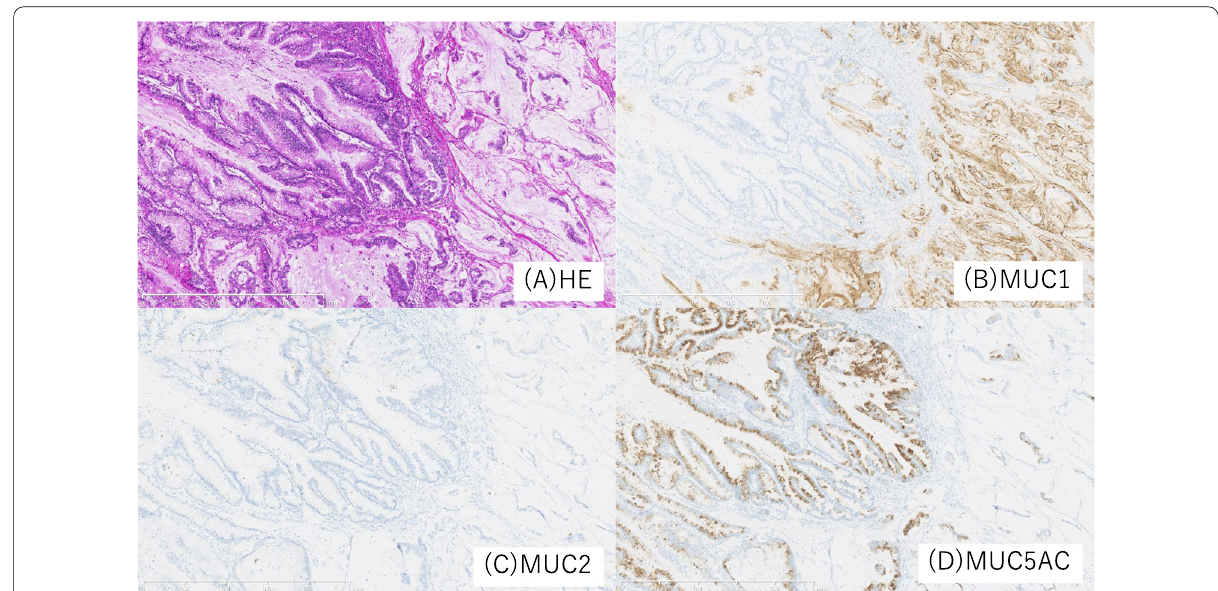
Fig. 6 Histopathological findings of the recurrent lesion. A Hematoxylin and eosin staining findings. On the left side of the image, the recurrent tumor shows papillary proliferation that resembles the finding shown in Fig. 5A. Mucus production was observed in the atypical epithelial cells, as with the primary lesion. On the right side of the image, the tumor is expanding beyond the mucosa. B The tumor with a papillary structure was almost MUC1-negative; however, the tumor that exhibited invasion was MUC1-positive. C , D The tumor was MUC2-negative and